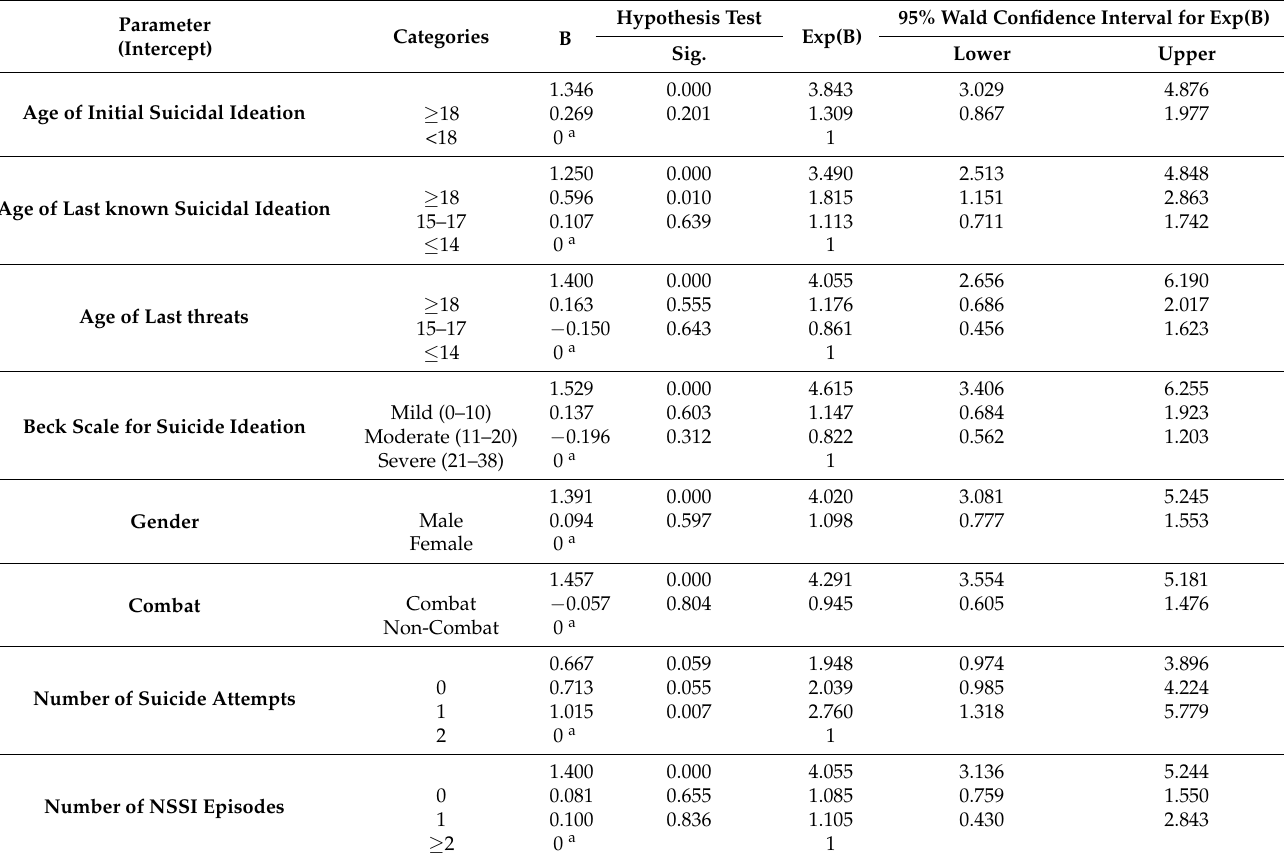
Table 3. Multivariate Analysis (GLM)* of Potential Clinical Severity of the Soldiers’ Most Recent Suicide Attempt (N = 65). Parameter (Intercept)